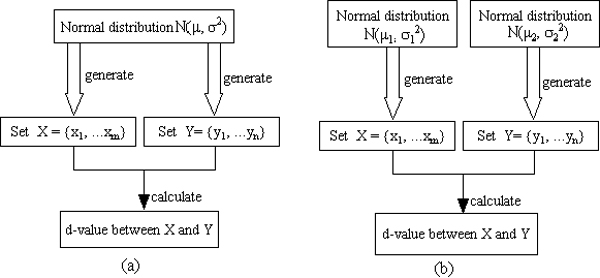
Random generation of d-value from normal distribution. (a) shows the random generation of two sets of values from the same normal distribution and the calculation of the FM d-value of these two sets. (b) shows the random generation of two sets of values from two different normal distributions and the calculation of FM d-value of these two sets.